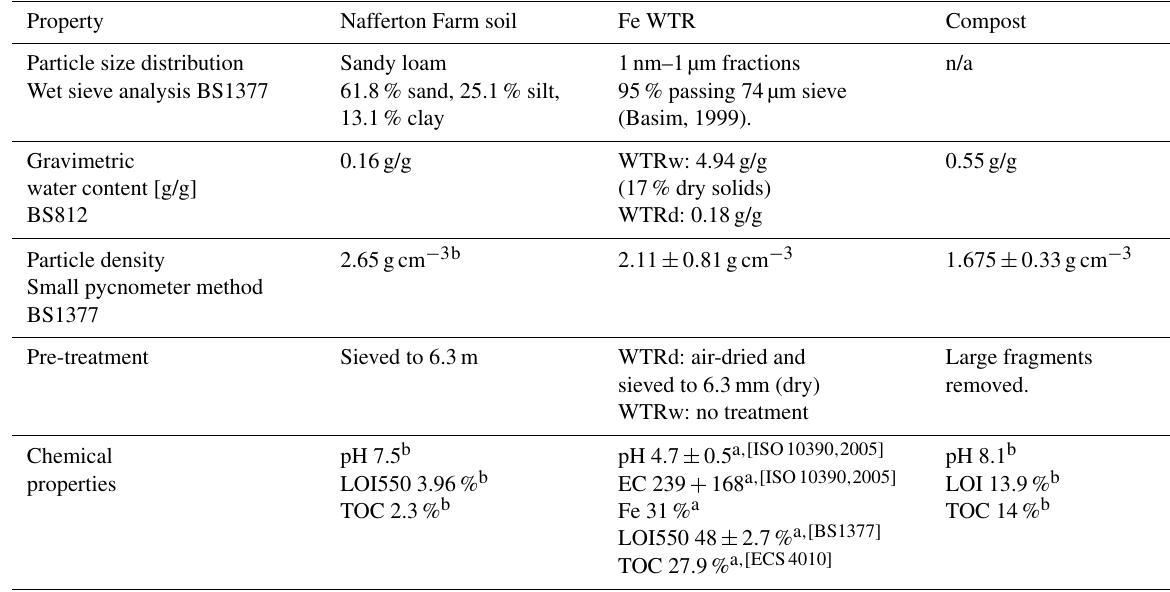
Table 2. Material properties and preparation. Data annotated with “a” are sourced from Finlay (2015). ICP-MS pseudo-total metal concen- tration for Fe was carried out as per Finlay (2015). Data annotated with “b” were obtained by DETS